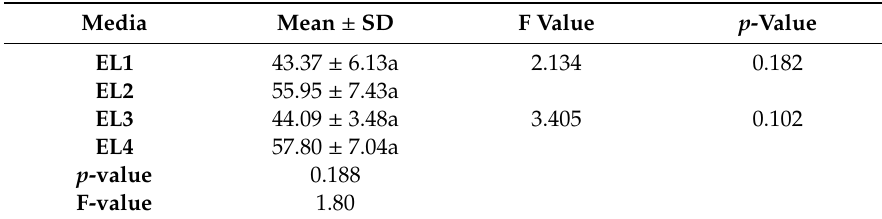
Table 5. Comparison of means survival percentage after 6 weeks in elongation media. All values are means ± SD.